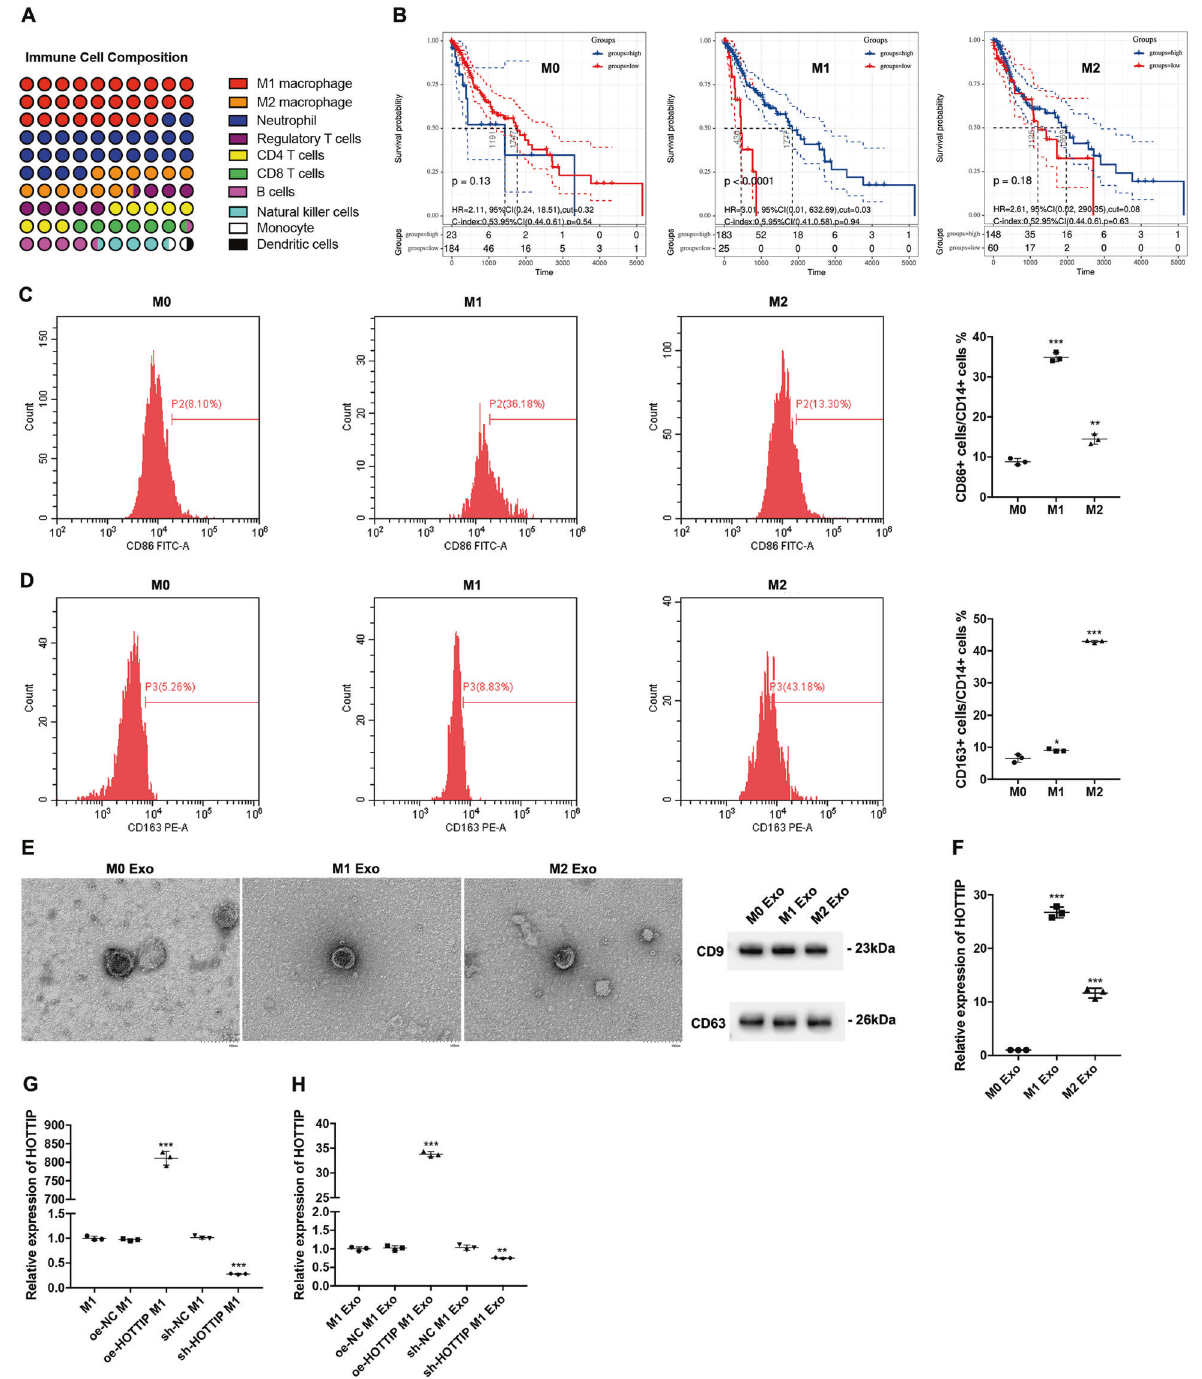
Fig. 1 The correlation between TAMs and HNSCC prognosis and the establishment of HOTTIP overexpression and knockdown exosomes in M1. A The in fi ltration levels of immune cells in HNSCC. B Prediction of overall survival according to high- and low-in fi ltration levels of M0, M1 and M2 macrophages. THP-1-derived M0, M1 and M2 macrophages were con fi rmed by fl ow cytometry using ( C ) CD14 plus CD86 and ( D ) CD14 plus CD163 ( n = 3). E The exosomes were extracted from three types of macrophages and con fi rmed by electronic microscopy and Western blot analysis using CD9 and CD63. F RT-qPCR was conducted to test the expression of HOTTIP in M0, M1 and M2 macrophages ( n = 3). RT-qPCR was conducted to test the expression of HOTTIP in wild type M1 macrophages, HOTTIP-overexpressed and HOTTIP-knockdown M1 macrophages ( G ) and their exosomes ( H ) ( n = 3). Data are presented as mean ± SD. Results were analyzed by One-way ANOVA with a post hoc t -test. Signi fi cance: * P < 0.05, ** P < 0.01, *** P < 0.001.